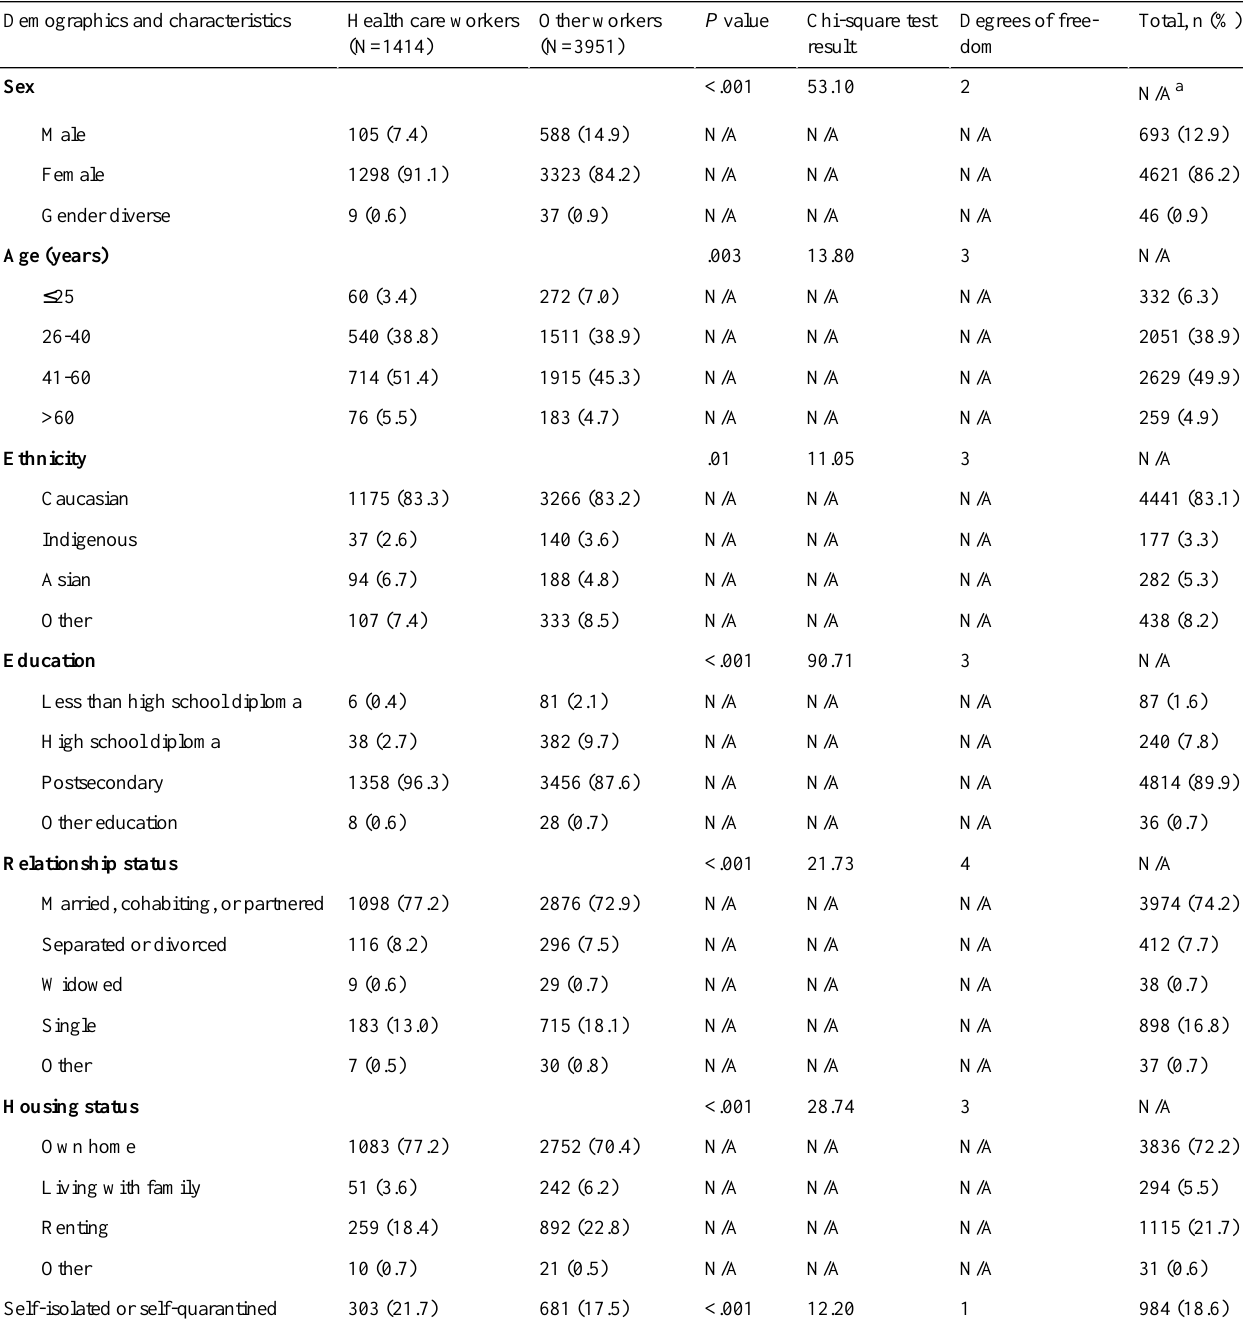
Table 1. Demographic characteristics of employed survey